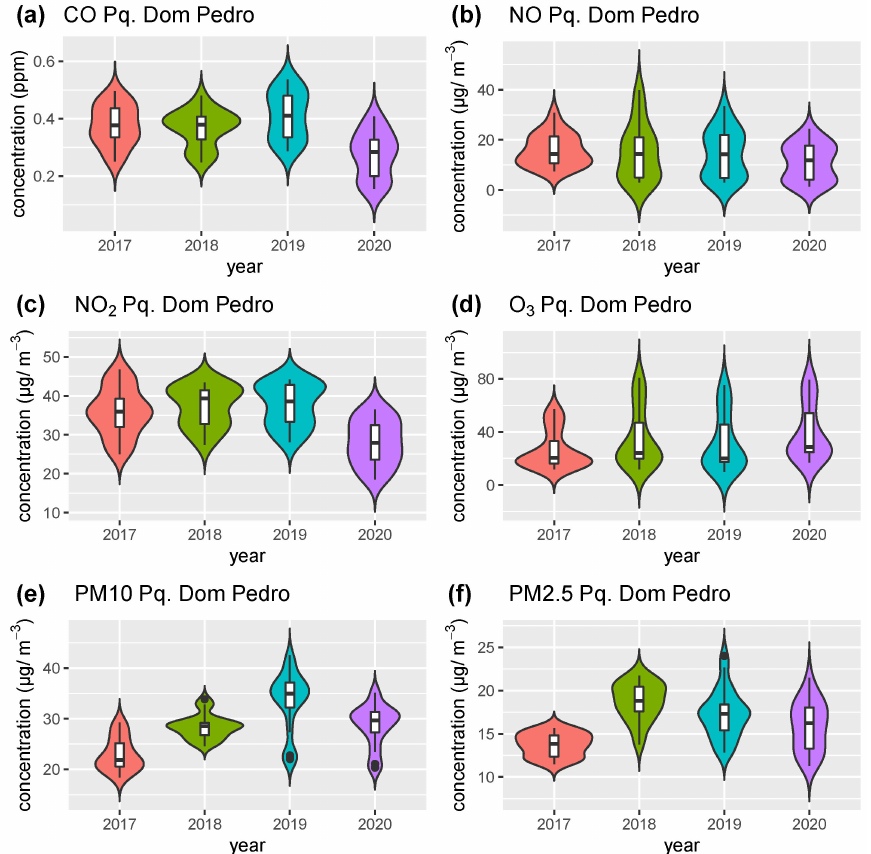
Figure 15. Violin graphs for Parque Dom Pedro station during April to May of 2017 to 2020 from ground